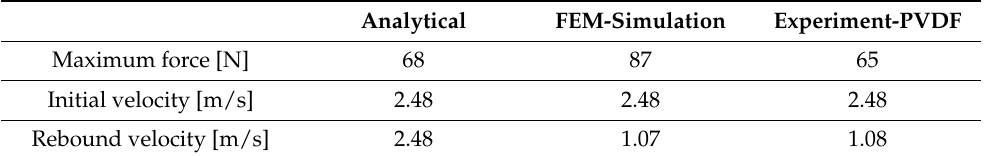
Table 2. Results obtained from the analytical and numerical approach compared with the experimen- tal data.